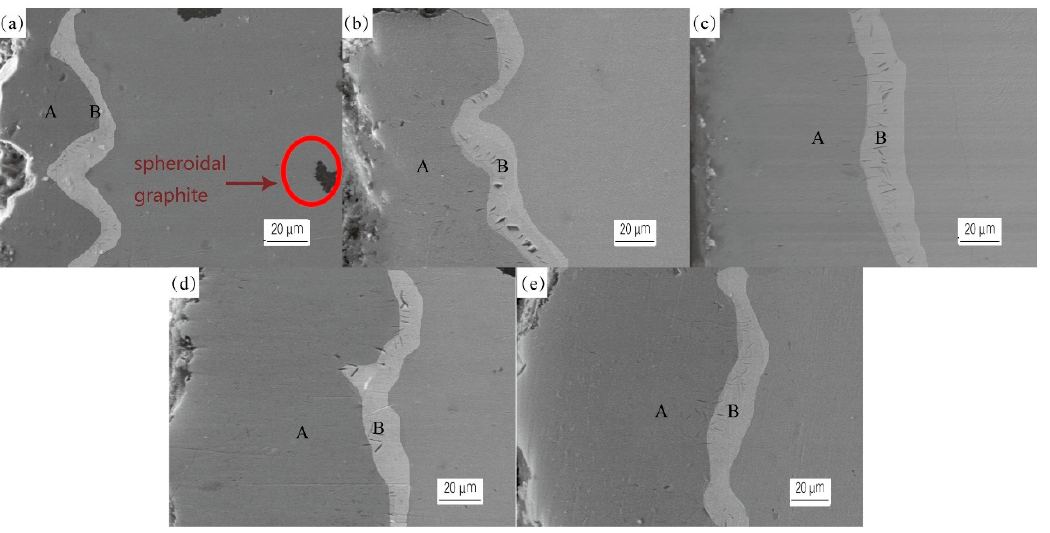
Figure 1. The cross-sectional microstructures of aluminizing samples at 830 °C ( a ) for 1 h; ( b ) for 2 h; ( c ) for 3 h; ( d ) for 4 h; ( e ) for 5 h.